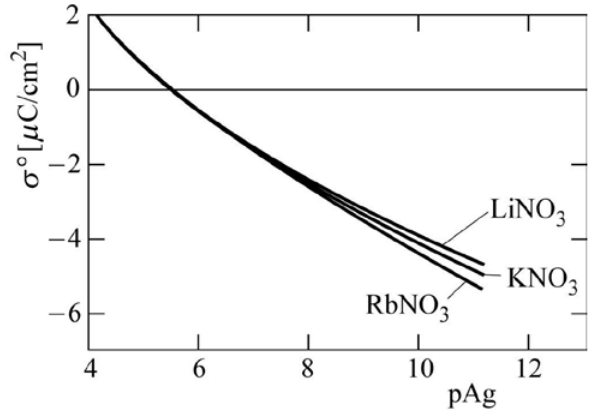
Figure 4. The surface charge on AgI as a function of the pAg in decimolar solutions of the indicated electrolyte, that is the order of magnitude of the c c . Reproduced from B.H. Bijsterbosch, J. Lykle- ma, Adv. Coll. Interface Sci. 1978 , 9 , 147, Copyright 1978, with per- mission from